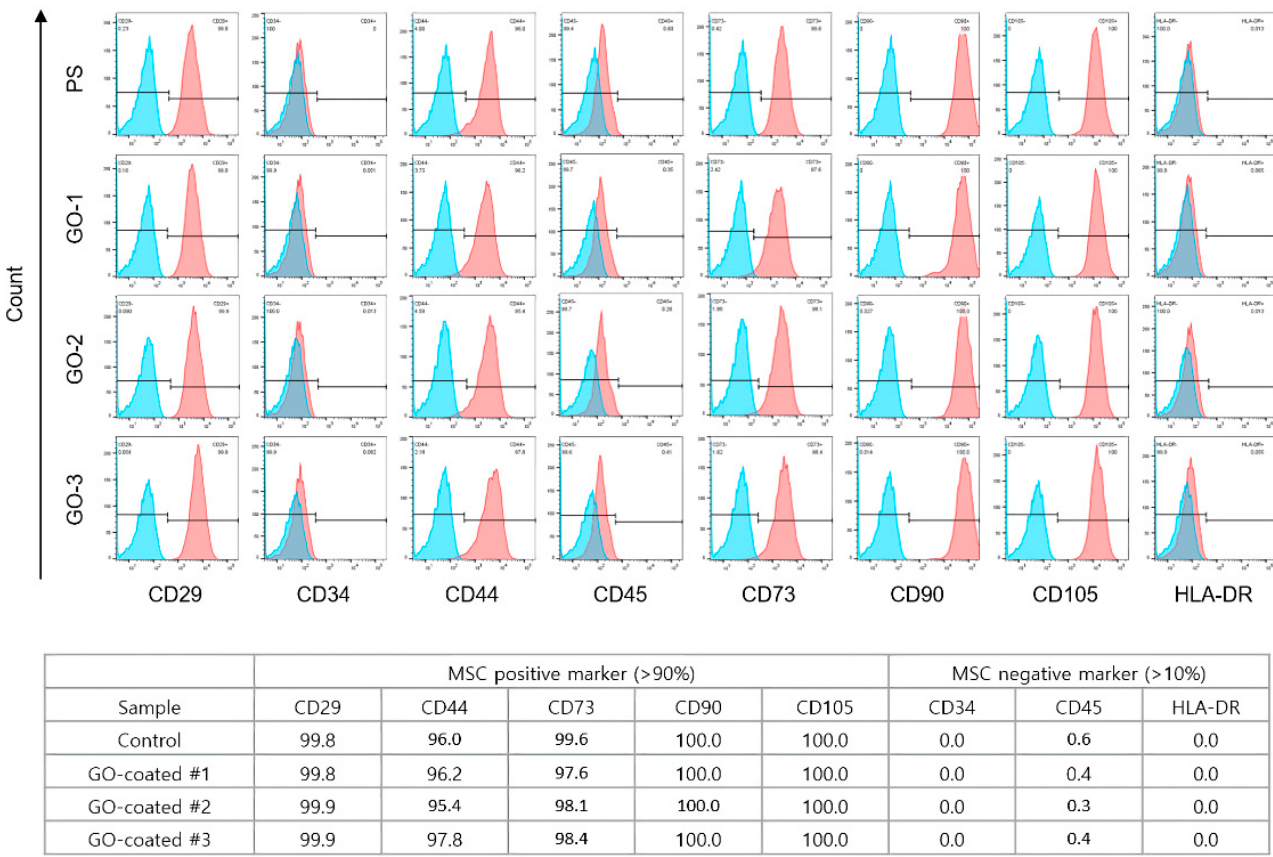
Figure 11. Flow cytometric analysis of MSC markers. The expression of MSC positive markers was all over 95% and of MSC negative markers was less than 1%.